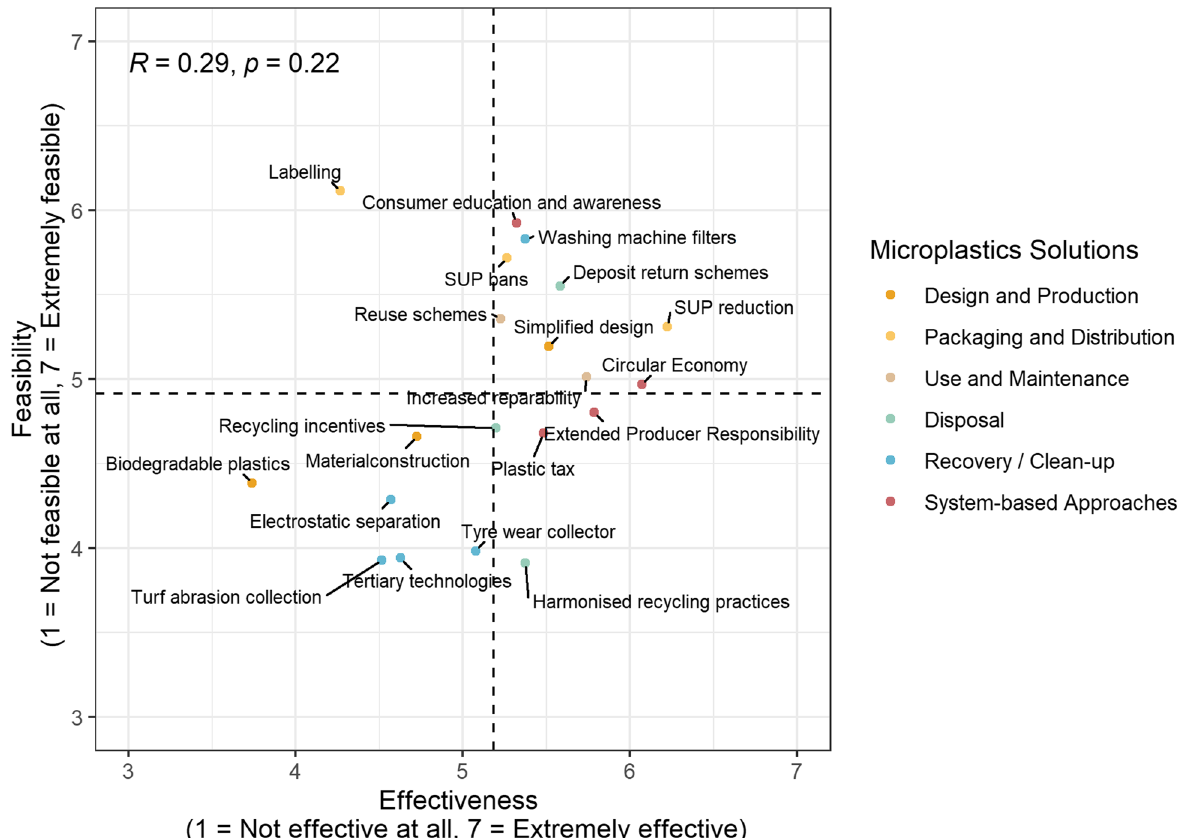
Fig. 4 Distribution of potential microplastics solutions across the plastic life cycle and system-based approaches separated into four different categories according to their effectiveness (below or above M Effectiveness